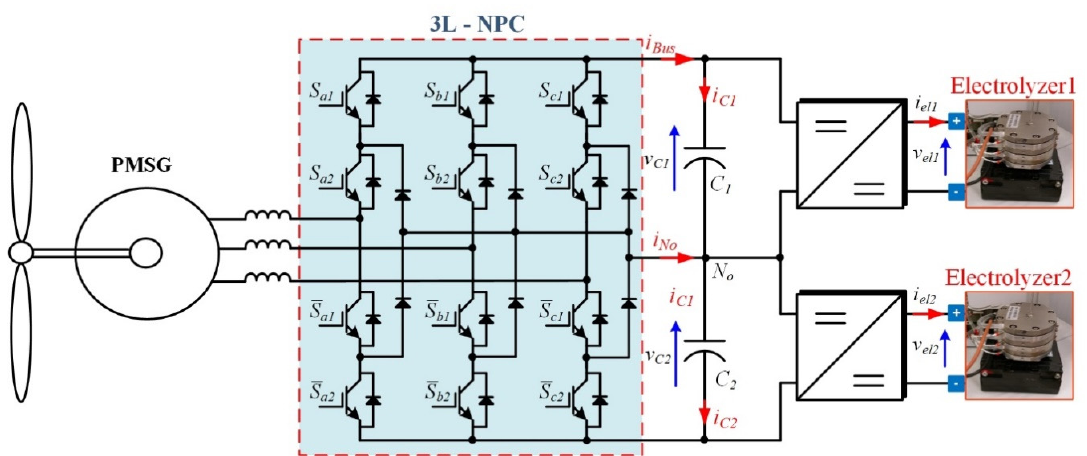
Figure 8. Hydrogen production systems supplied by wind energy with front-end based on multilevel rectifier.